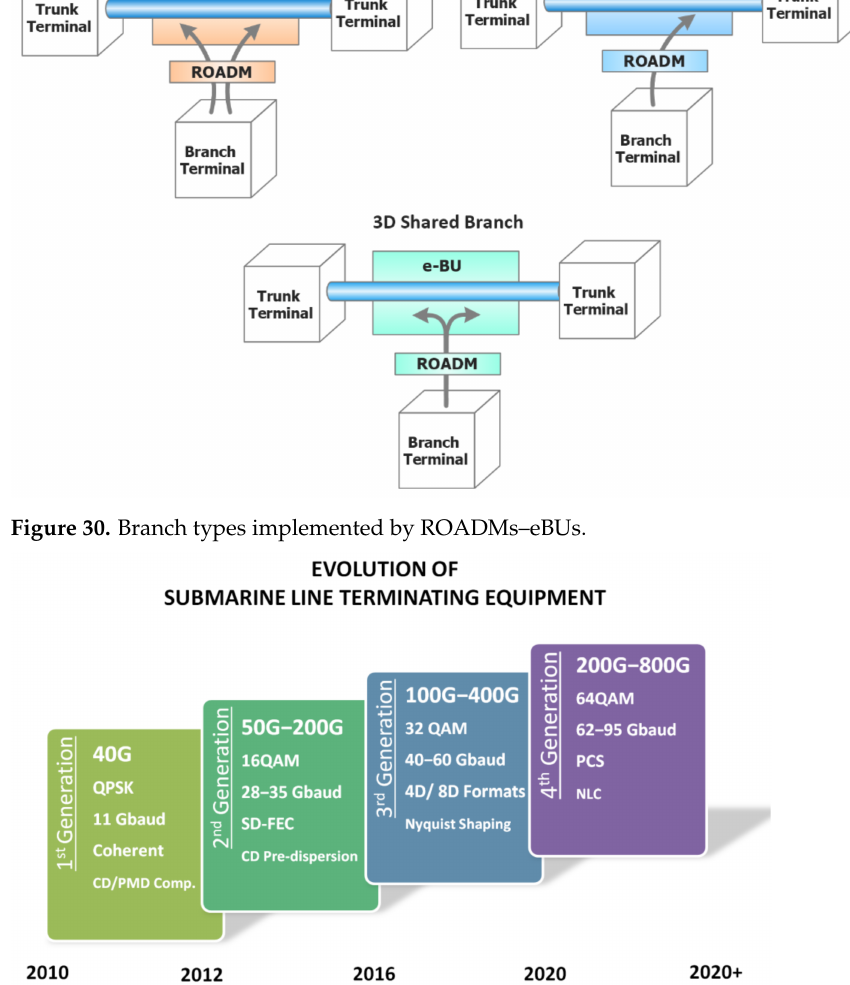
Figure 31. Evolution of submarine line terminating